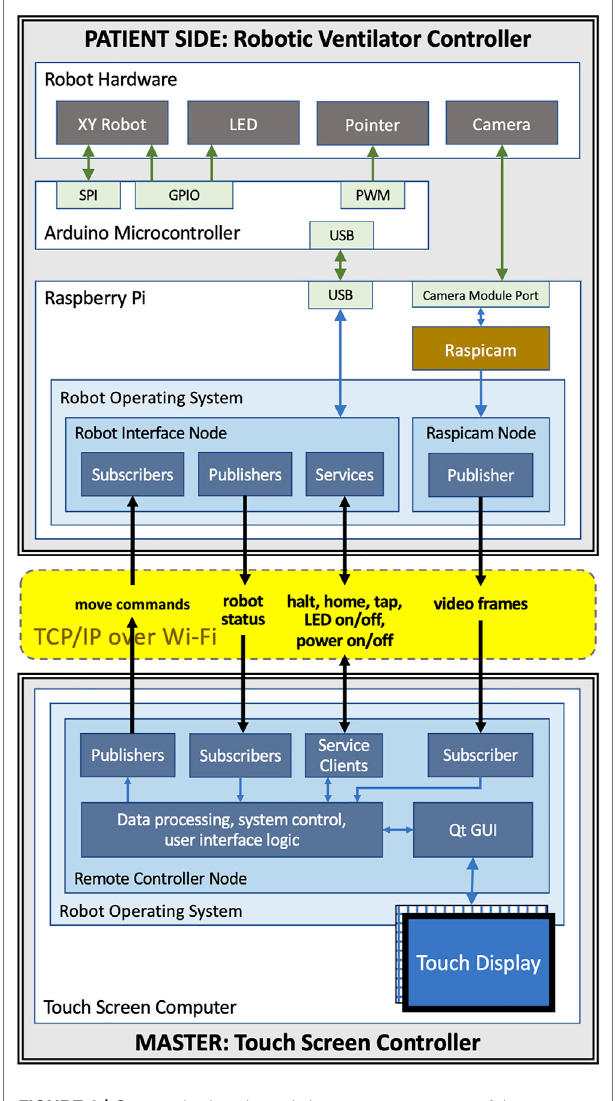
FIGURE 3 | Communication channels between components of the teleoperated system: the master and patient side devices communicate with each other using ROS topics and services over WiFi; the patient side Raspberry Pi is connected to the Arduino that controls the motors, the end-effector, and the LED using USB; the camera is connected to Raspberry Pi using the Pi ’ s camera module port.